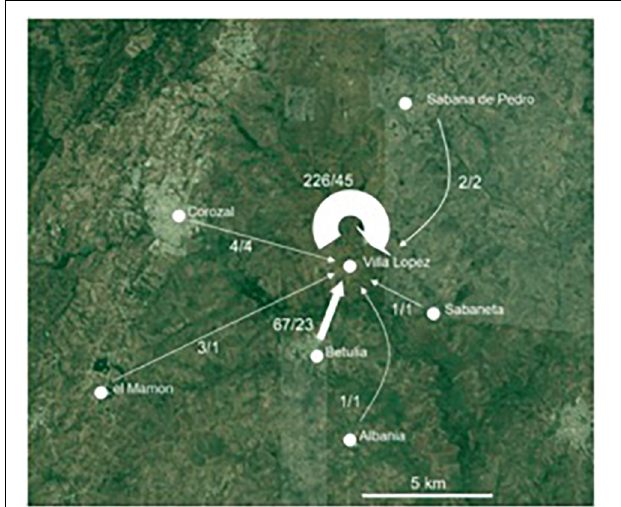
FIGURE 2 | Cassava stem cuttings circulation among farmers from Villa López and from neighboring villages. A transaction is described as cuttings of a given variety provided by a farmer to a farmer from Villa López. The size of the arrow is proportional to the number of transactions and the direction of the arrows shows the provenance of cuttings planted in Villa López (from donors to receivers). Numbers: the number of incoming transactions/number of donors from each neighboring village. This figure only focuses on stem cuttings received in Villa López, since they may imply the transfer of Xpm in the village.